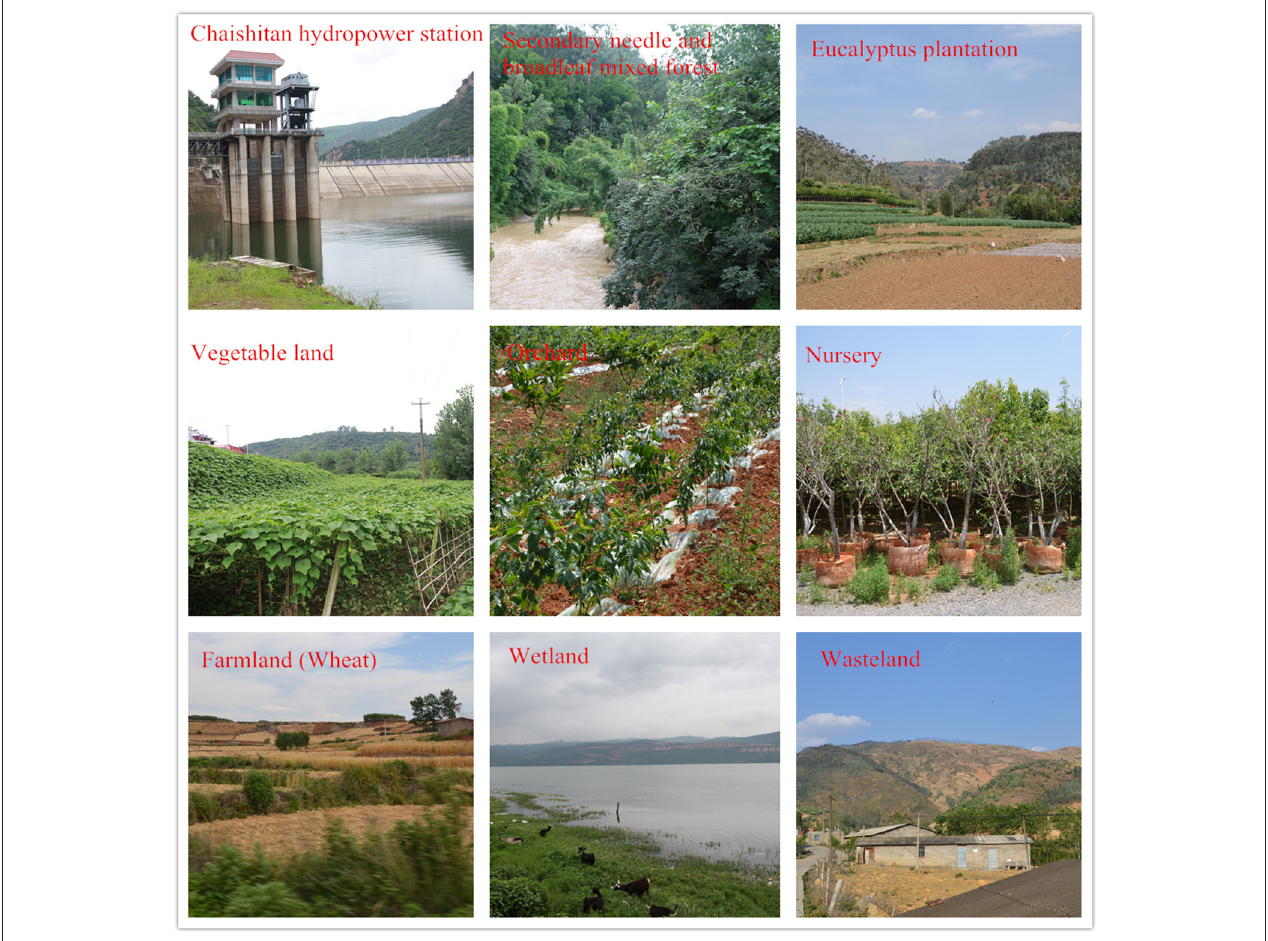
FIGURE 3 | The main land use types in Chaishitan irrigation